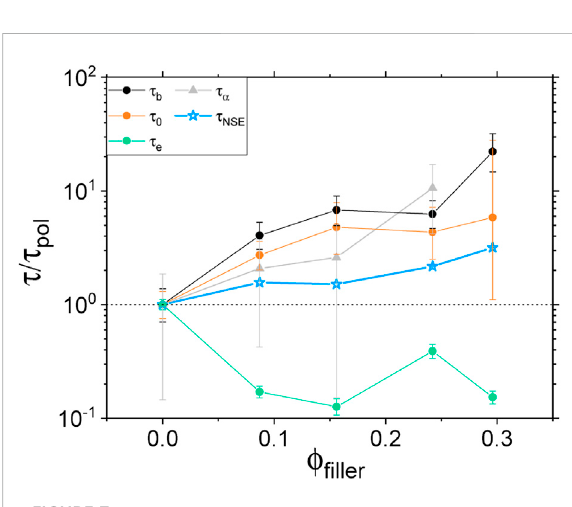
FIGURE 7 Rheological, dielectric and NSE characteristic times (circles, triangles and stars respectively) normalized by the respective neat polymer value τ pol and plotted as a function of the volume fraction of fi llers. Rheological and NSE data are taken at 413 K and dielectric data at 253